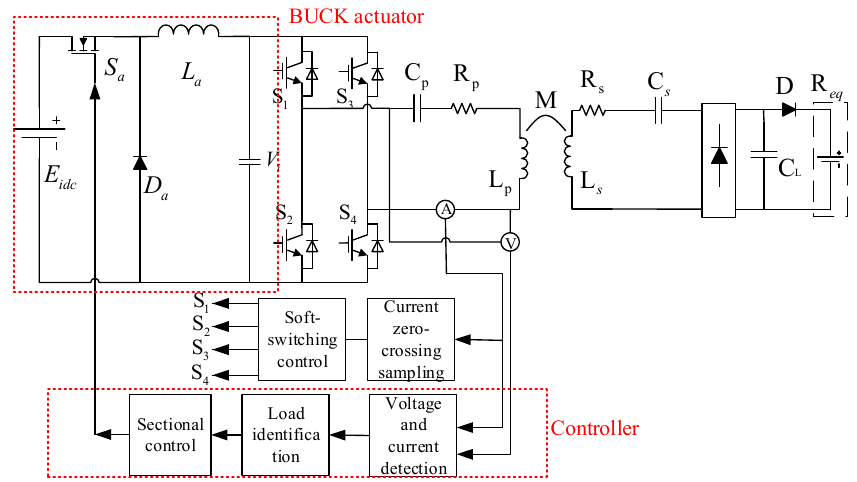
Figure 1. Diagram of SS type lithium ion battery wireless charging system.